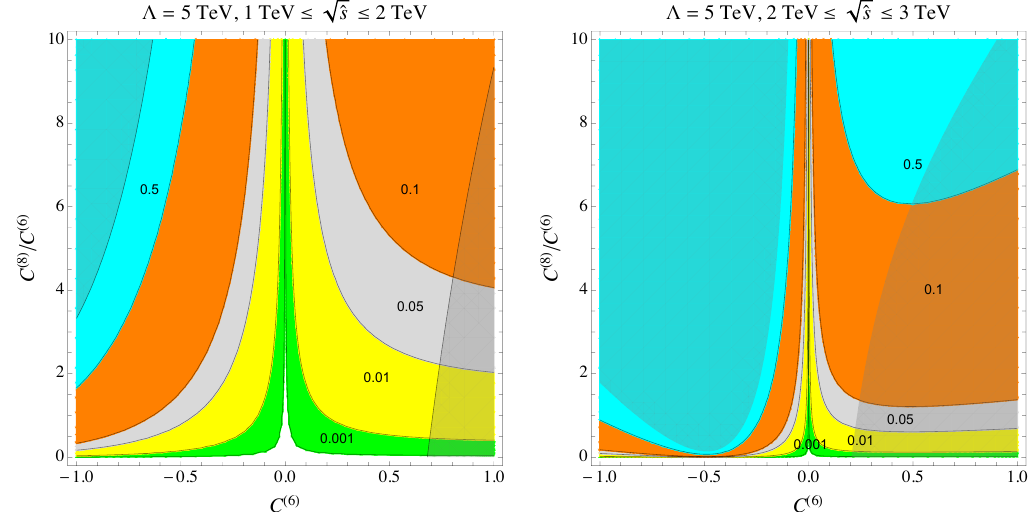
Figure 3 . Dimension eight operator contribution to σ ( pp → ‘ + ν ) in the center of mass energy √ √ range 1 TeV ≤ ˆ s ≤ 2 TeV (left panel) and 2 TeV ≤ ˆ s ≤ 3 TeV (right panel) compared to the full O (1 / Λ 4 ) result with the dimension eight coefficients shut off: | ( σ ( pp → ‘ + ν ) − σ ( pp → O (1 / Λ 4 ) ‘ + ν ) no dim-8 ) /σ ( pp → ‘ + ν ) | plotted as a function of the dimension six Wilson coefficient O (1 / Λ 4 ) strength C (6) = [ − 1 . 0 , 1 . 0] and the ratio of the dimension eight coefficient strength relative to the dimension six coefficient (taking all dimension eight coefficients to be equal), C (8) /C (6) = [0 . 1 , 10] . The new physics scale Λ = 5 TeV in both panels. The shaded region indicates where the SMEFT contribution is larger than the SM contribution (either positive or